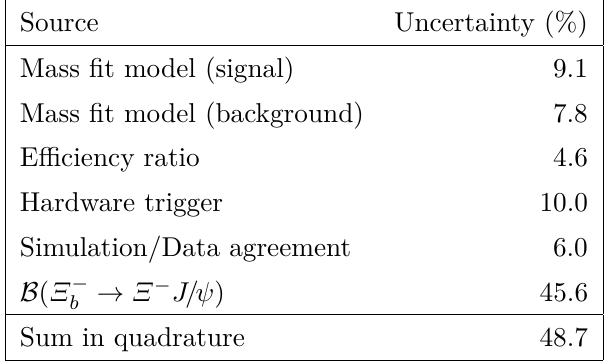
Table 2 . Dominant systematic uncertainties on the measurement of the branching fraction B ( Ξ − → Ξ − γ b